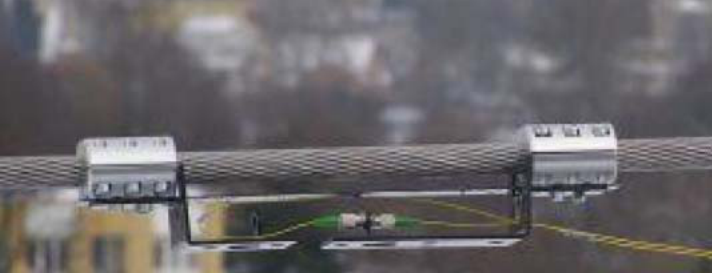
Figure 13. CFBG for overhead transmission line sag detection reported by Wydra et al. Image from [78].